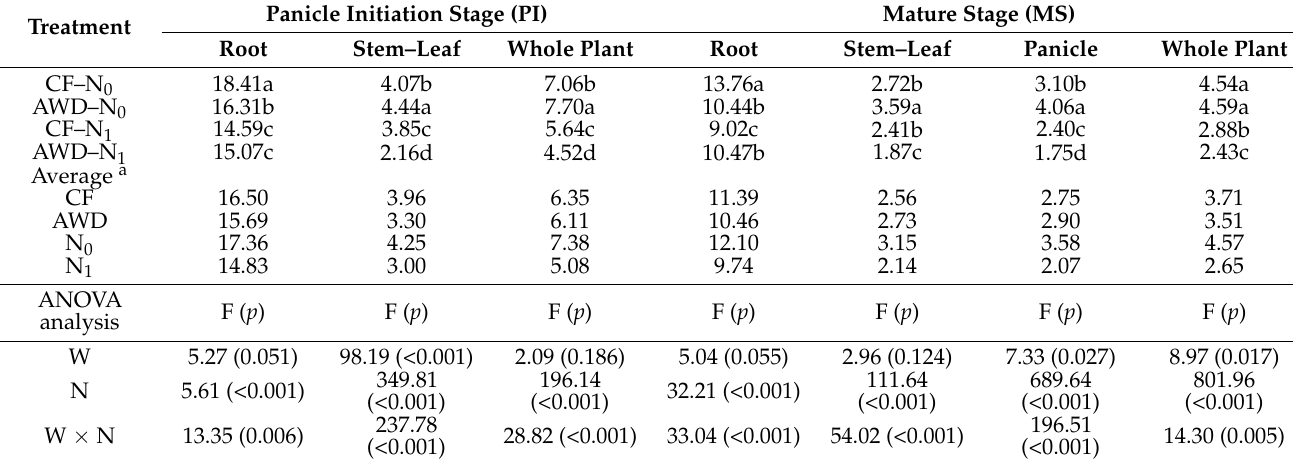
Table 3. Contribution of straw-N to total N of various plant parts under different treatments